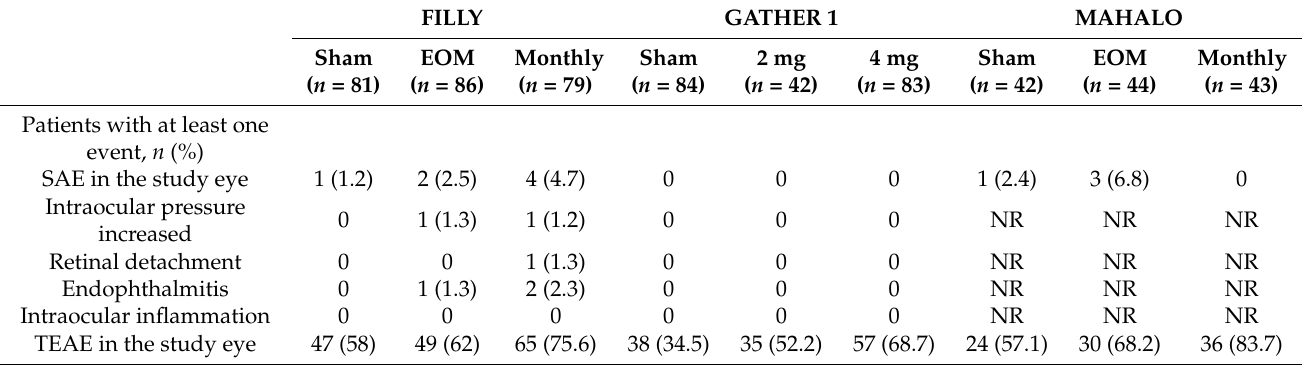
Table 4. Rates of SAEs and TEAEs in the FILLY, GATHER 1 and MAHALO studies. FILLY GATHER 1